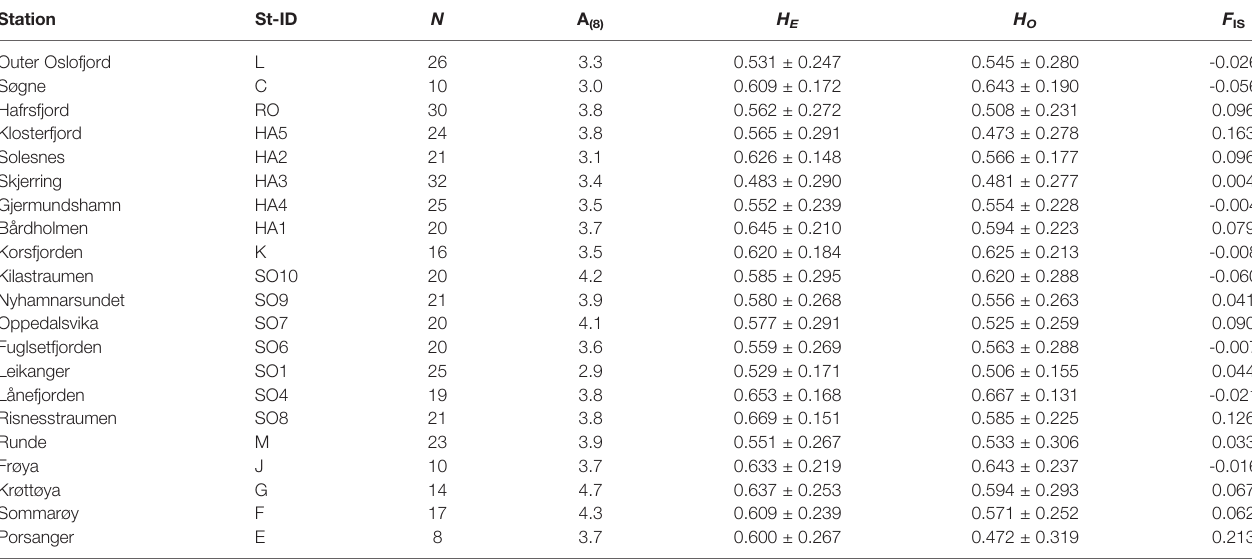
TABLE 2 | Station, Station-id, number individuals ampli fi ed ( N ), allelic richness standardized to smallest sample size (A (8) ). Station St-ID N A (8) H E F